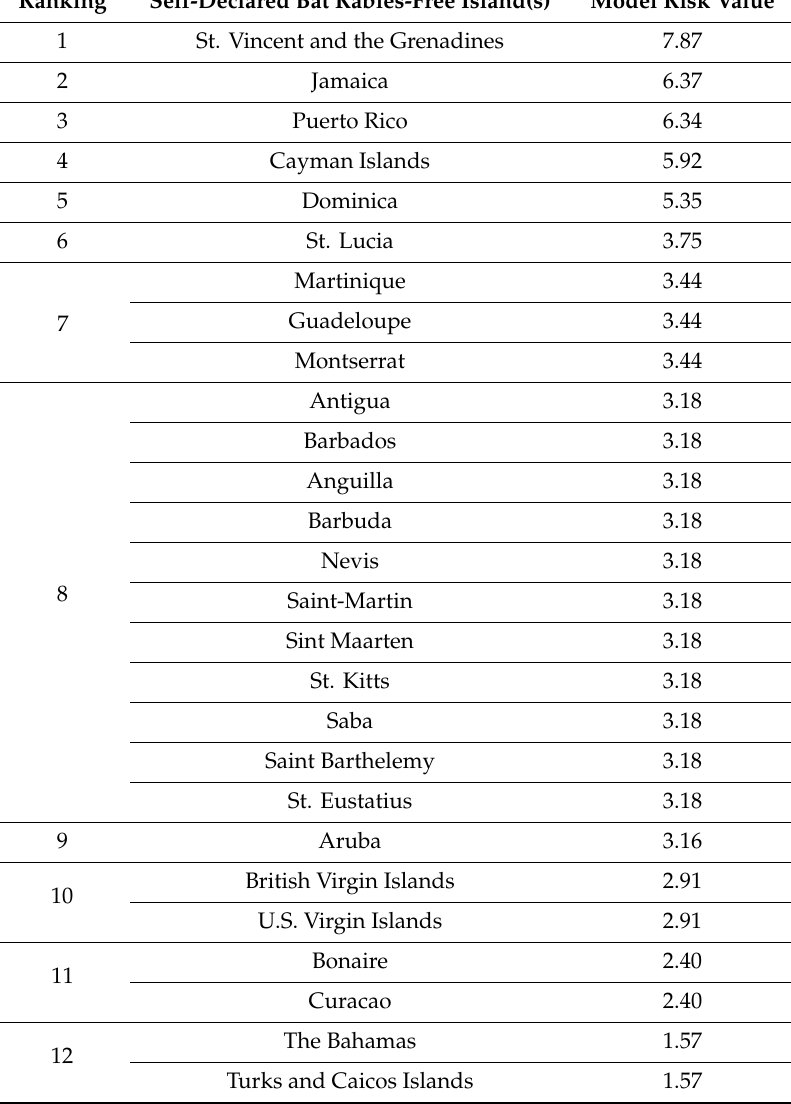
Table 4. Risk values of self-declared bat rabies-free islands from the risk